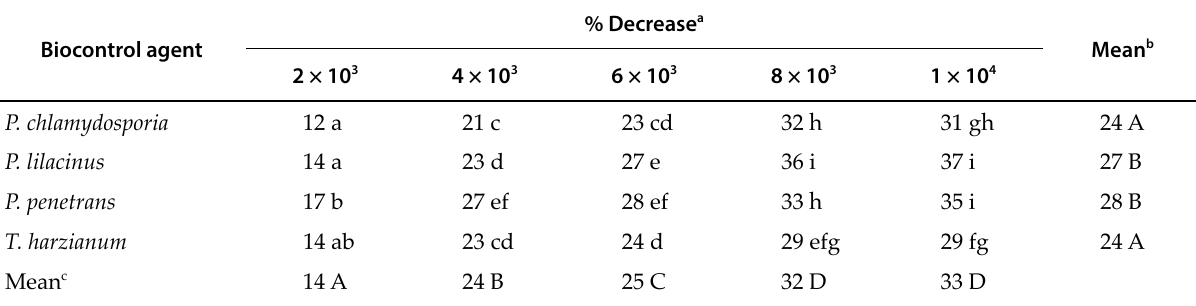
Table 6. Mean proportional decreases in number of galls on okra plant roots after treatments with different nematode bio - control agents applied at different propagule